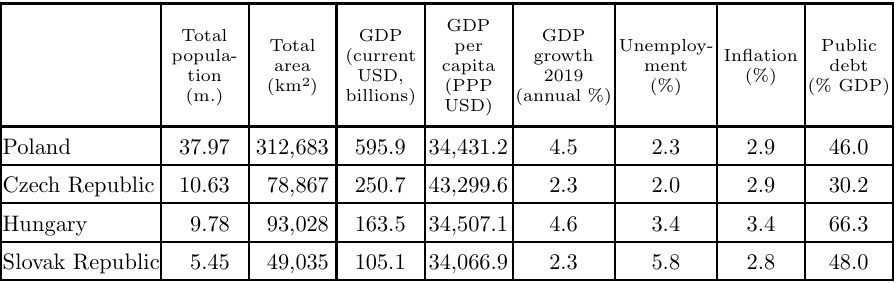
Main indicators of the V4 countries, 2019 Total popula- tion